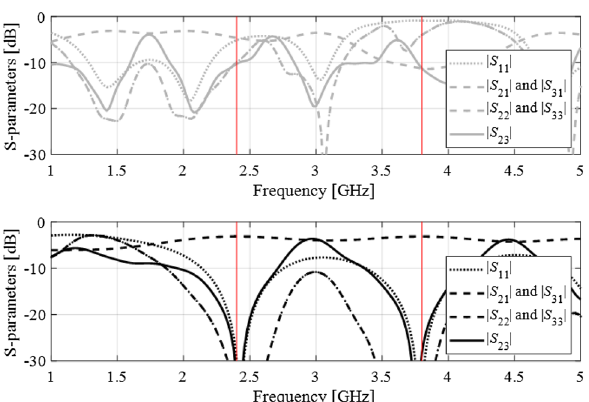
Figure 14. Dual-band power divider: scattering parameters at the initial (top) and the final design (bottom) obtained using the proposed design specification management methodology. Target operating frequencies marked using the vertical